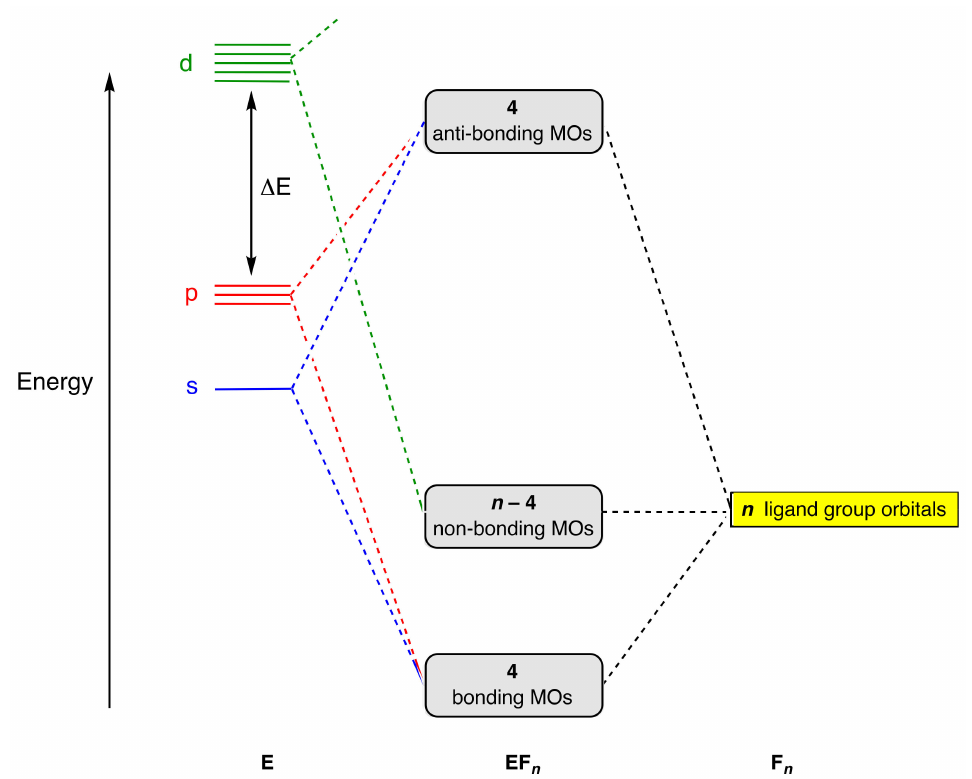
Figure 4. A general, σ -only MO scheme for compounds of the type EF n , where E exhibits its maximum or group valence showing closed-shell structures for SiF 4 (T d , 8e), PF 5 (D 3h , 10e), SF 6 (O h , 12e), IF 7 (D 5h , 14e), and XeF 8 (D 4d , 16e). In each case, the central atom E can be viewed as having an octet of electrons in bonding orbitals, whereas the non-bonding electrons are largely or exclusively localised on the ligand (F) atoms. XeF 8 is unknown, but the isoelectronic anion [IF 8 ] − has been characterised. This diagram is also applicable to ionic species that are isoelectronic with neutral EX n compounds where E exhibits its maximum valence such as [AlF 4 ] − , [AlF 5 ] 2 − , [AlF 6 ] 3 − , [SiF 5 ] − , [SiF 6 ] 2 − , [PF 6 ] − , [TeF 7 ] − , and [IF 6 ] +